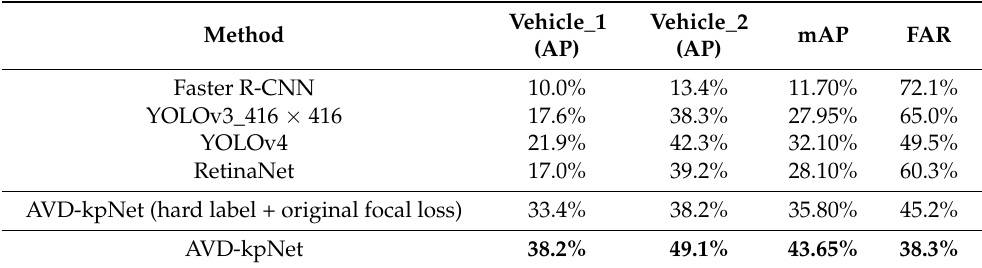
Table 1. Comparisons of different methods on two kinds of object. The bold value indicates the best performance of each